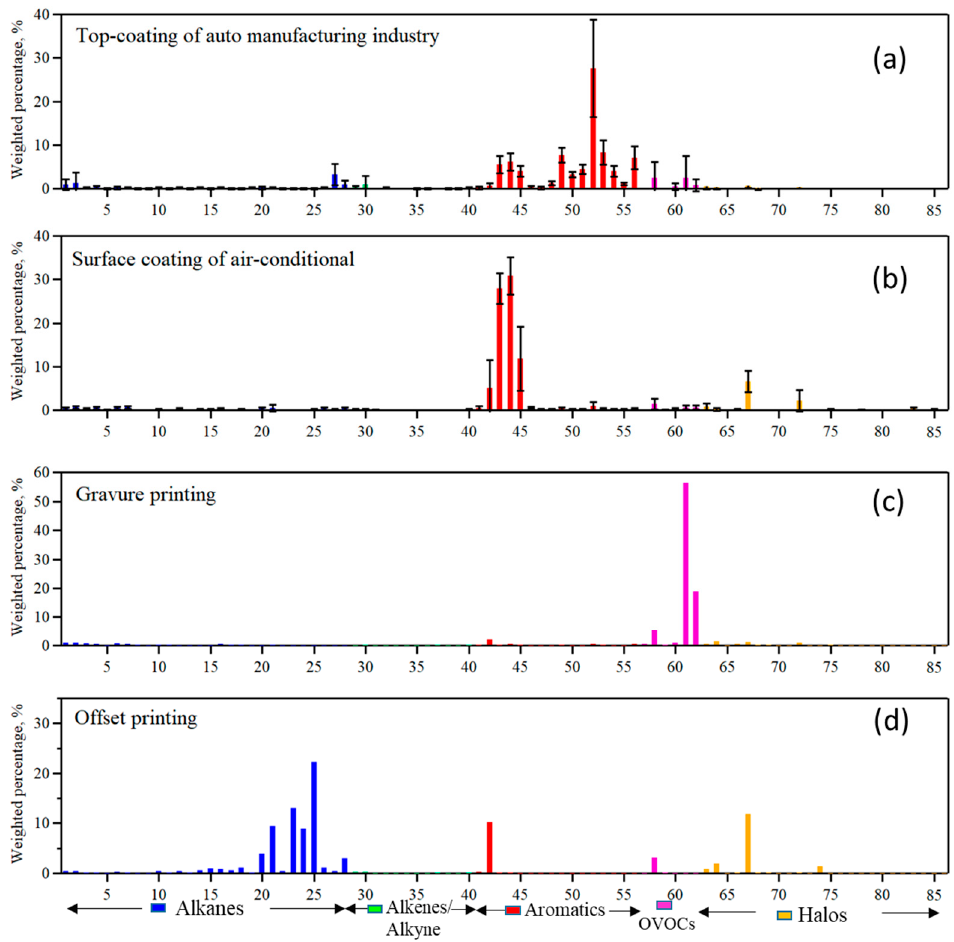
Figure 6. VOCs source profile for surface coating and printing ( a ) auto manufacturing ( b ) air-conditional industry ( c ) gravure printing ( d ) offset printing.